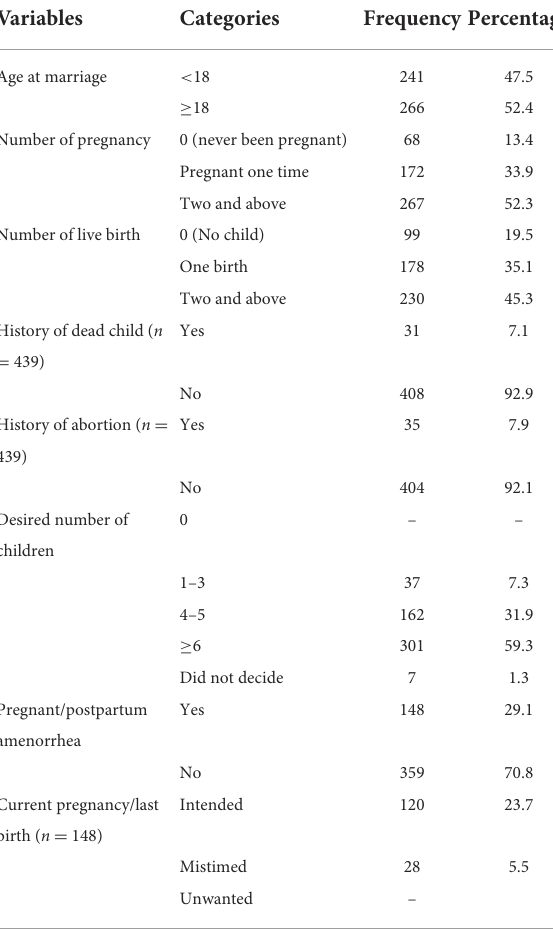
TABLE 2 Reproductive characteristics of young married women in the Haramaya HDSS, eastern Ethiopia,